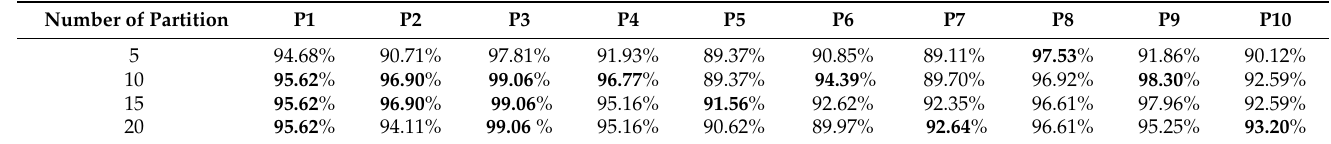
Figure 12. Illustration of human body posture and his projection histogram. First row presents the human silhouette postures which are standing, sitting, lying and bending postures. Second row notices the correspond projection histogram which are the intersection between horizontal and vertical partition. Table 7. The number of partition evaluation for features extraction.